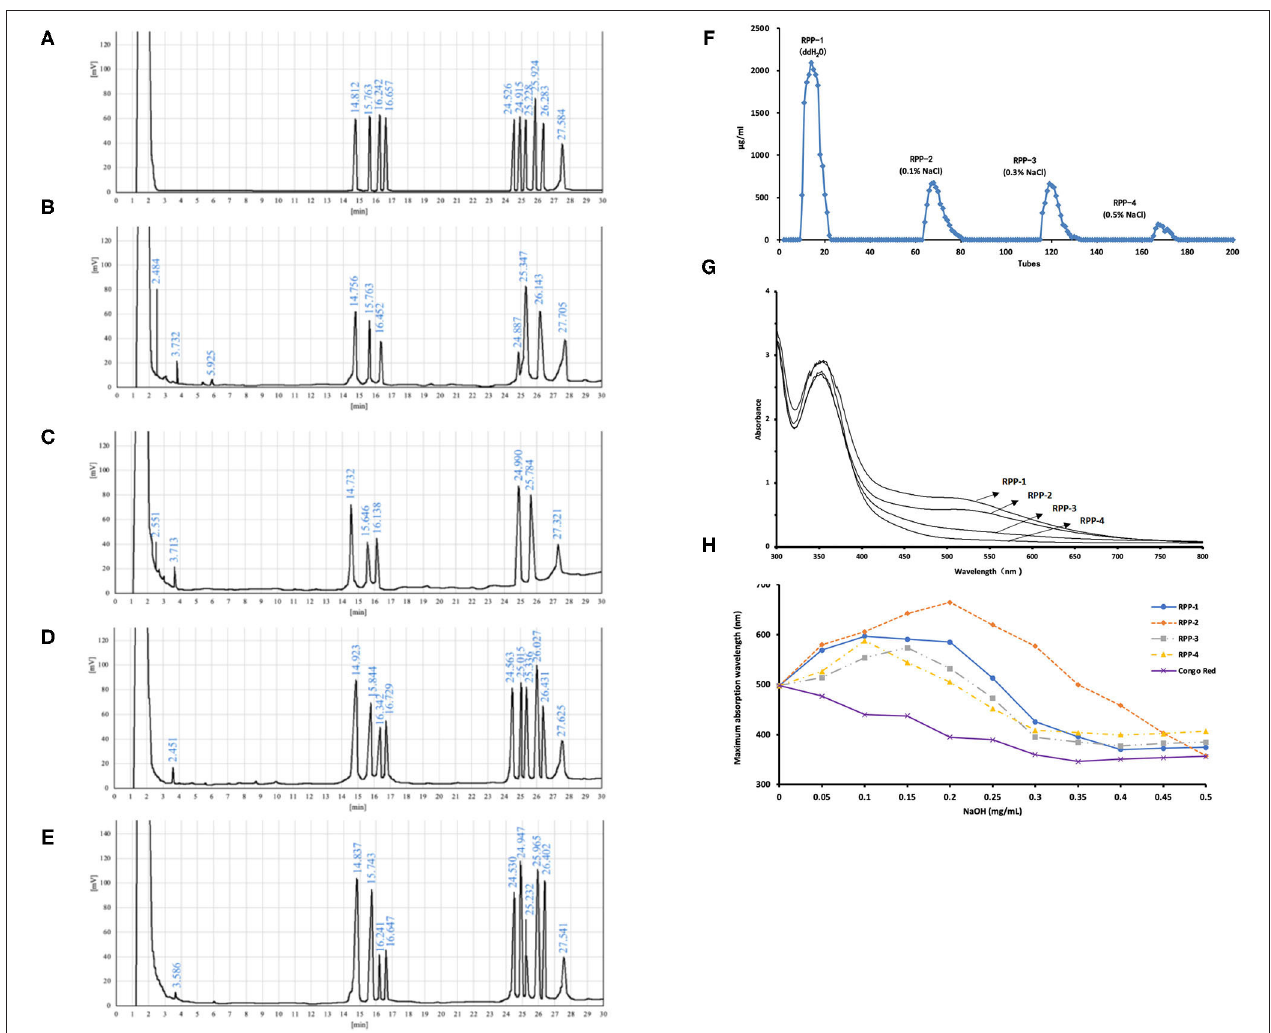
FIGURE 2 | Purification and monosaccharide composition of RPPs and their ultraviolet (UV)-visible (vis) spectra. (A) Gas chromatography (GC) of monosaccharides and internal standard, L-rhamnose, D-xylose, D-arabinose, D-ribose, D-fructose, D-mannose, D-glucose, D-galactose, D-fucose, and inositol (from left to right). (B–E) Hydrolyzed production of RPP-1, RPP-2, RPP-3, RPP-4, and inositol. Purification of RPPs and their UV-vis spectra. (F) DEAE-cellulose anion-exchange chromatography of DPPs. (G) UV-vis spectrum of the RPPs and the iodine-potassium iodide reagent. (H) Maximum absorption wavelengths of RPPs and Congo red complex increases under alkaline conditions.